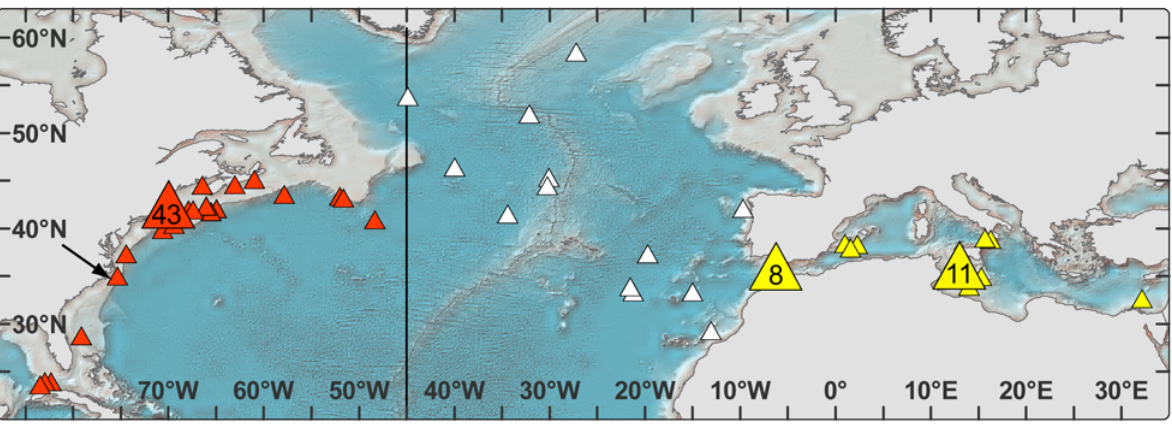
Figure 2. Recovery positions of electronic archival tags (triangles) in western Atlantic (orange, n=64, 226 6 21 cm CFL), eastern Atlantic (white, n=13, 218.4 6 13 cm CFL), and Mediterranean Sea (yellow, n=29, 234 6 17 cm CFL). Line at the 45 u meridian indicates the management line. Black arrow indicates location of tag deployments in North Carolina. Large triangles with inset indicate locations of multiple recoveries. The highest recapture rates for these western tagged bluefin tuna were obtained from the region off New England (48% of total recaptures) followed by the Mediterranean Sea (27%). The Central and Northeast Atlantic emerged as the third area of high recovery (13%).